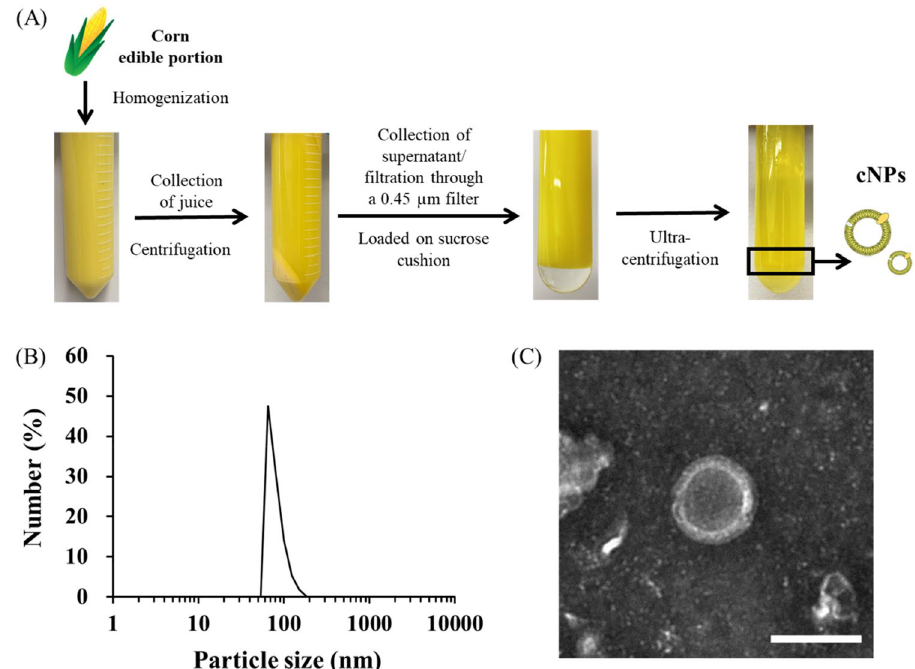
Figure 1. Preparation and characterization of cNPs. (A) Flow diagram of cNP preparation. Corn homogenate was obtained from the edible portion of corn using a food processor. The homogenate was centrifuged, filtered, and ultracentrifuged using a sucrose cushion. cNPs were then collected from the indicated phase (black rectangle). (B) Size distribution of cNPs was determined using ELSZ-2000ZS. (C) TEM image of cNPs was observed using H-7650 TEM. The scale bar indicates 100 nm.